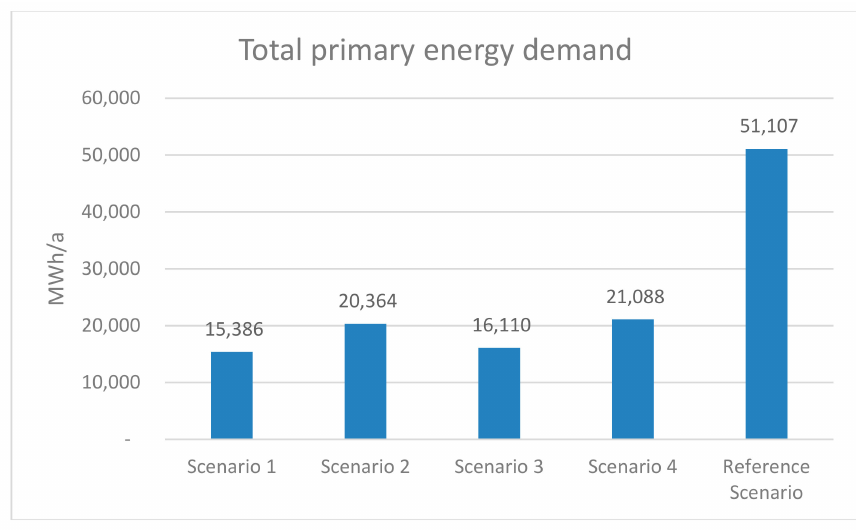
Figure 9. Total primary energy consumption by scenario.